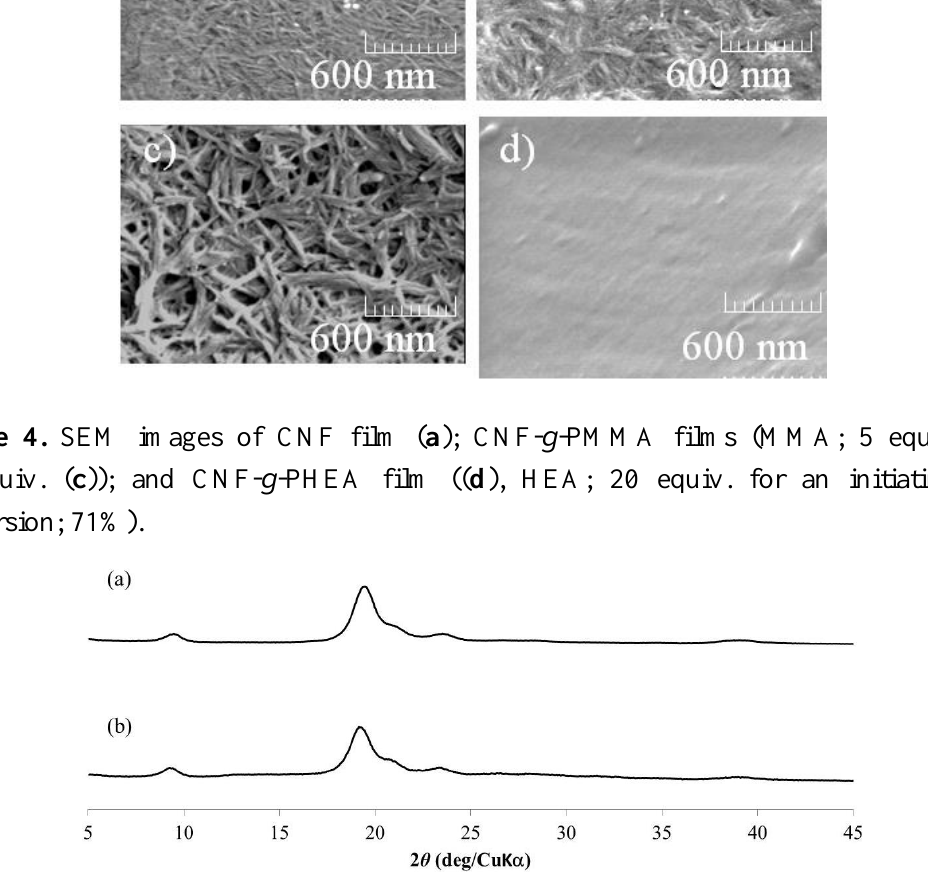
Figure 5. XRD patterns of CNF film ( a ) and CNF- g -PMMA film (( b ), MMA; 10